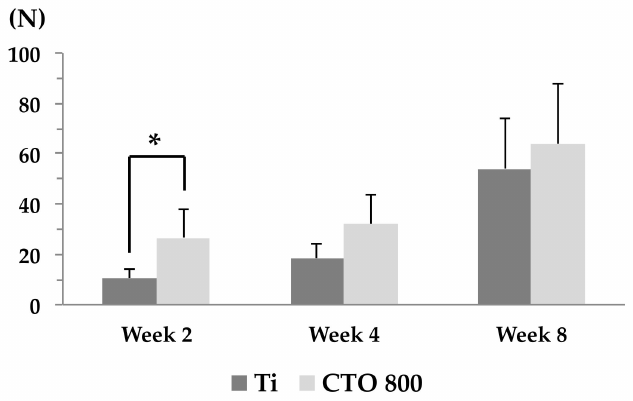
Figure 6. Push-in test values for Ti and CTO 800. Data are mean ± standard deviation ( n =